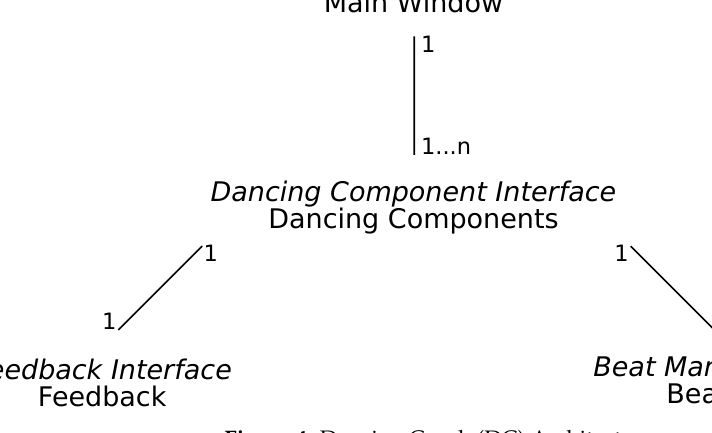
Figure 4. Dancing Coach (DC)